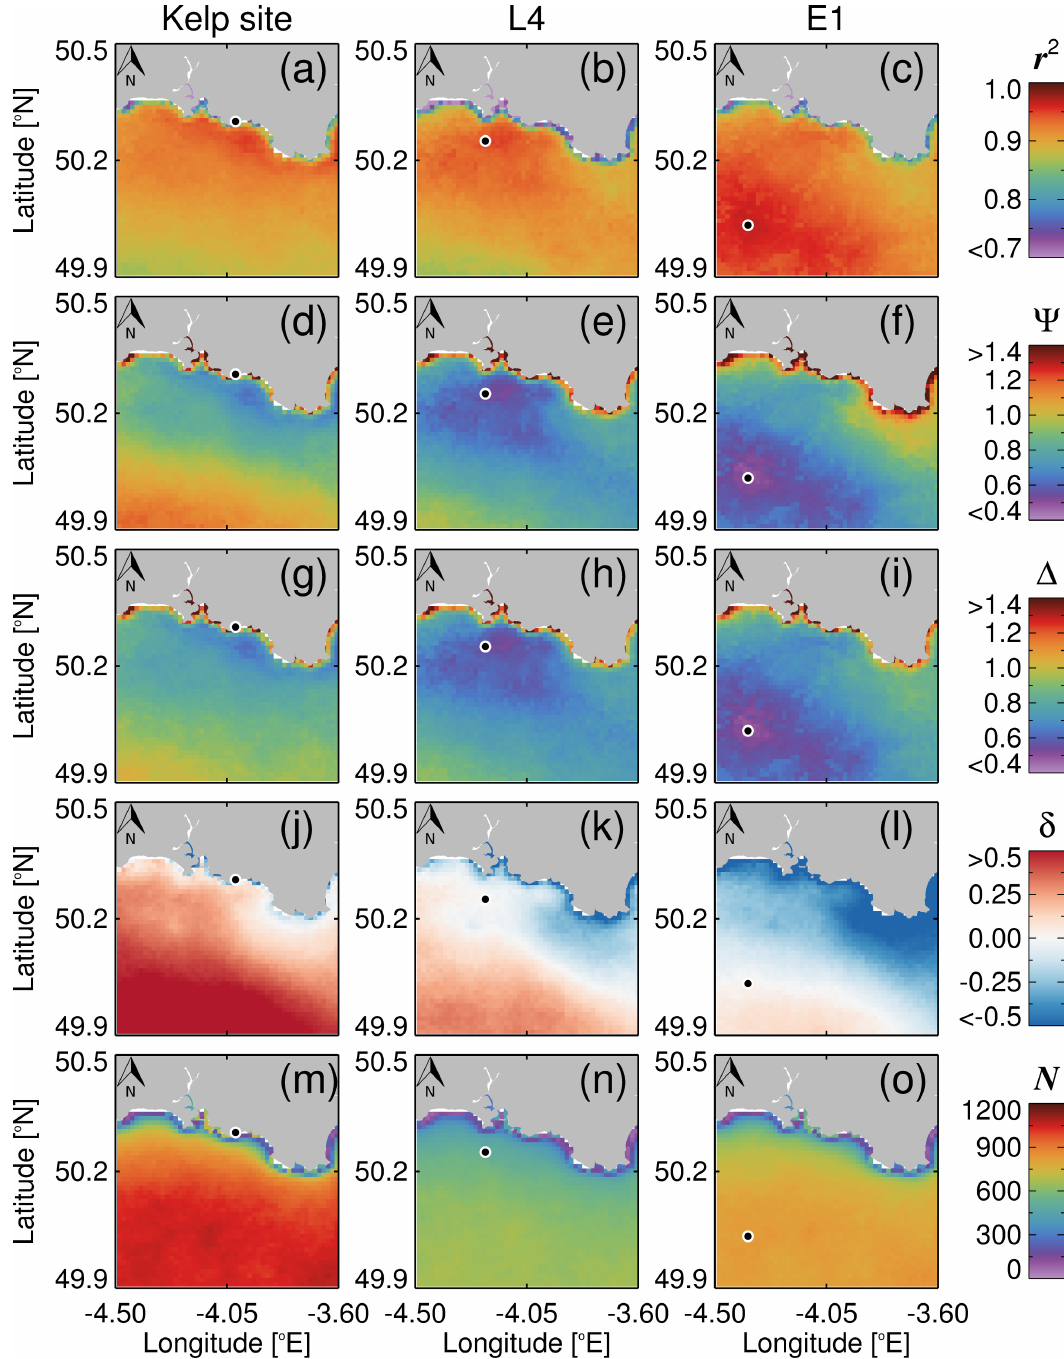
Figure 3. Spatial maps of statistical tests for match-ups within ± 1h of in situ data for all AVHHR SST N pixels within longitude − 4.5 to − 3.6 ◦ N and latitude 49.9 to 50.5 ◦ N. ( a , d , g , j , m ) show match-ups for the kelp site, ( b , e , h , k , n ) at Station L4 and ( c , f , i , l , o ) at Station E1. ( a – c ) is the coefficient of determination ( r 2 ), ( d – f ) the root mean square error ( Ψ ), ( g – i ) the centre-pattern (or unbiased) root mean square error ( ∆ ), ( j – l ) the bias ( δ ), and ( m – o ) the number of match-ups ( N